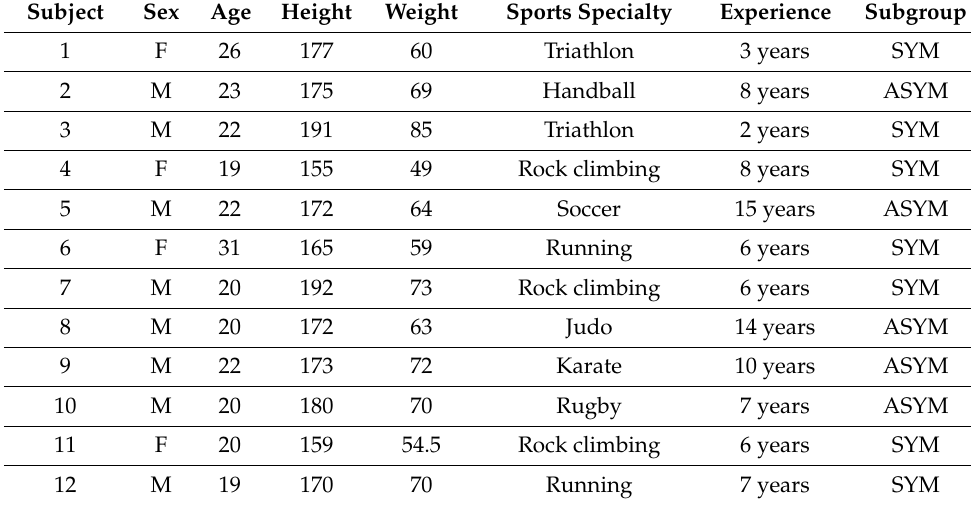
Table 1. Participants’ characteristics and experience in